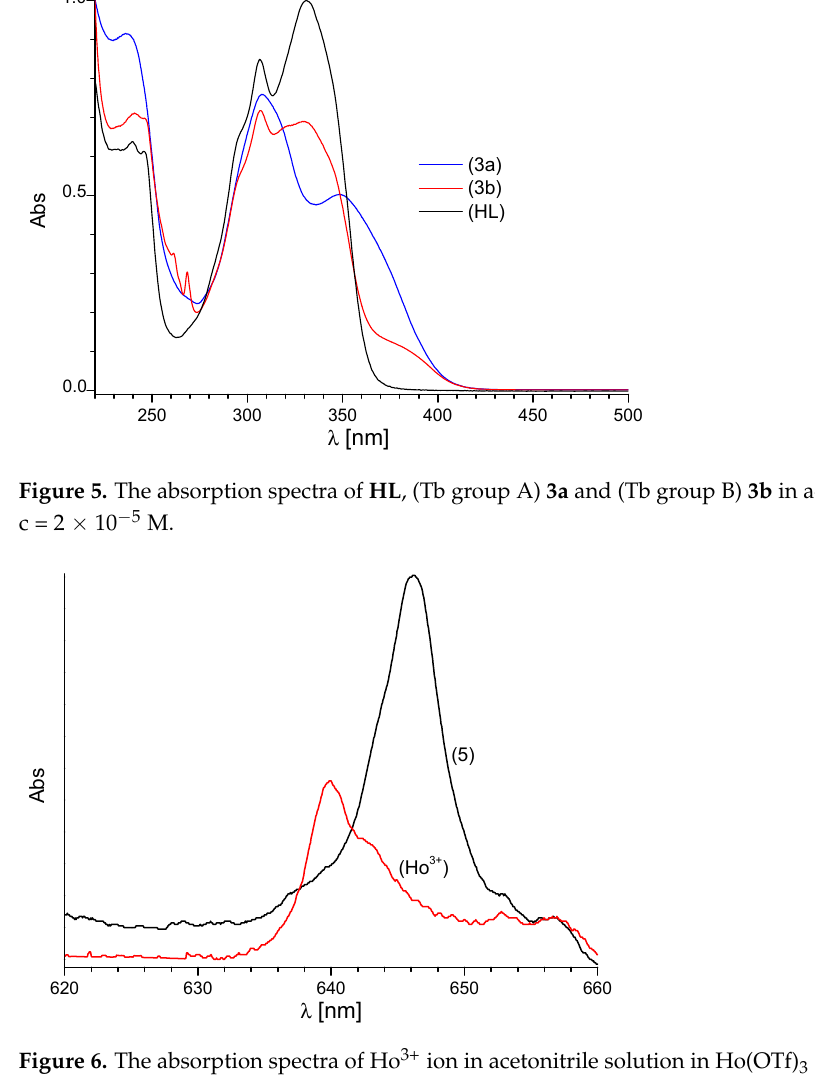
Figure 5. The absorption spectra of HL , (Tb group A) 3a and (Tb group B) 3b in acetonitrile solution; c = 2·10 − 5 M.